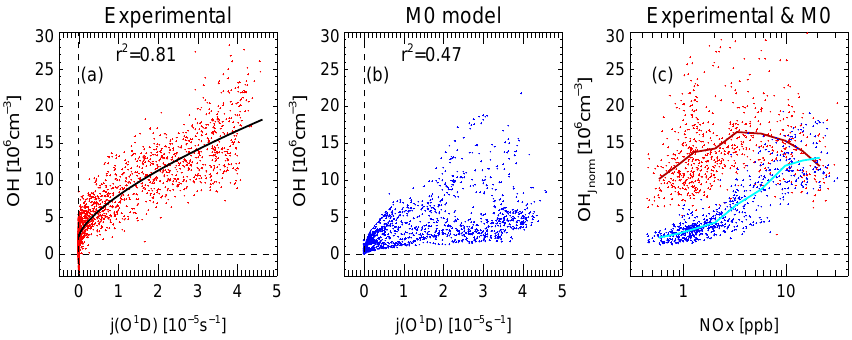
Fig. 8. Correlation of OH with j( O 1 D ) and NO x at PRD backgarden. Panels (a,b) show the measured and modelled (M0) dependencies of OH on j( O 1 D ) . The black line in panel (a) represents a Levenberg-Marquard fit to Eq. (2). The measured and modelled dependencies on NO x are shown in panel (c) denoted by red and blue symbols, respectively. Here, the OH data were first selected by j( O 1 D )> 1 × 10 − 5 s − 1 and then normalized to j( O 1 D ) (see text), denoted as OH Jnorm . The solid lines give the averaged values of the measured (red) and modelled (blue) OH Jnorm over equally spaced ln([NO x ]/ppb) intervals. Modelled curves for the scenarios M1, M2, M5b, M6b can be found in Fig. S3.